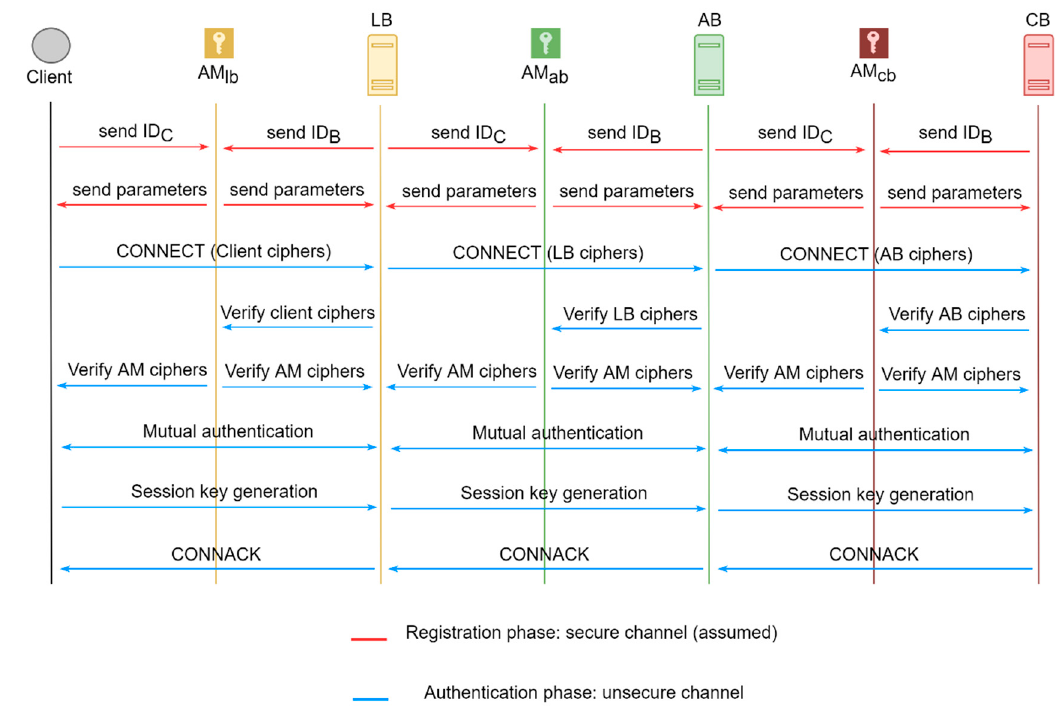
Figure 7. General interaction of the authentication scheme.